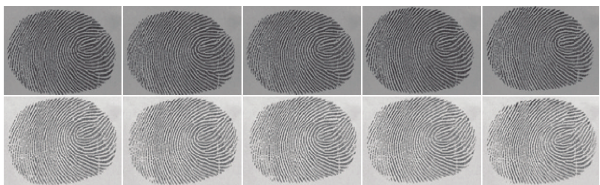
Figure 1: Ten sample images of one subject in the HRF